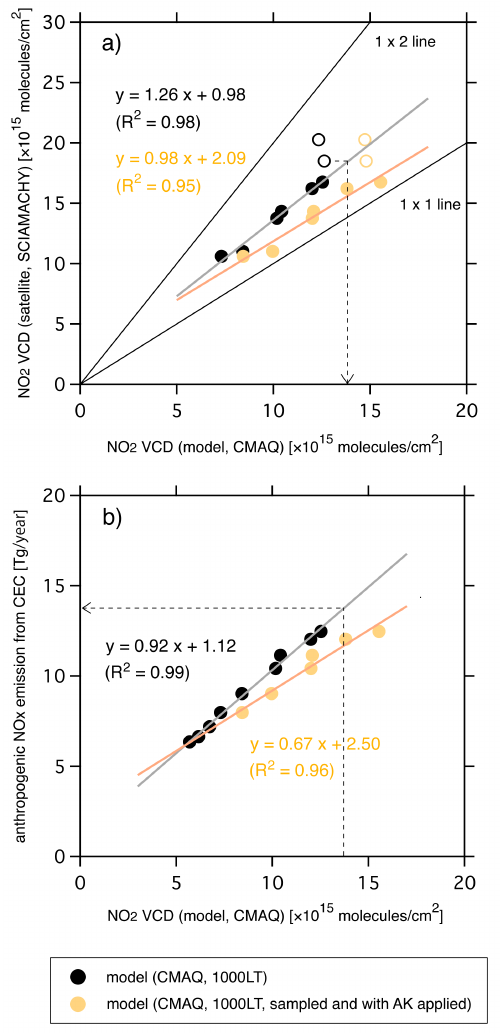
Fig. 6. Scatter diagrams of (a) annual-mean modeled and ob- served (SCIAMACHY) tropospheric NO 2 VCD above central east- ern China (CEC). Open circles denote sensitivity simulations with anthropogenic emissions fixed at 2008 values. (b) Annual-mean modeled tropospheric NO 2 VCD above CEC with annually-based anthropogenic NO x emissions from CEC. Symbol colors denote model results at 10:00LT (black circles), and model results sam- pled with valid pixels and the averaging kernel (AK) information of SCIAMACHY data applied (light-orange circles).